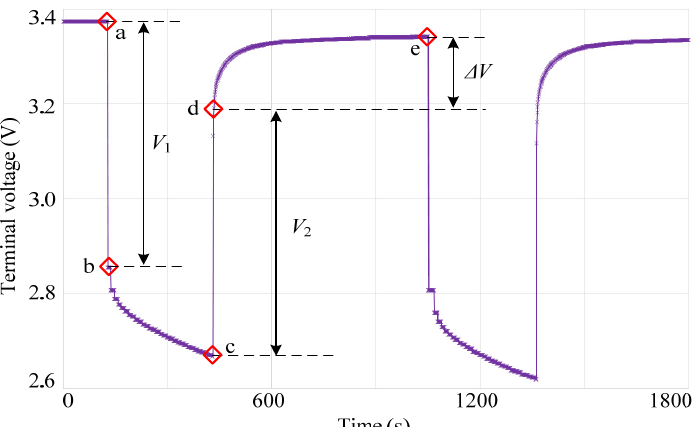
The functional relation between OCV and SOC is non-linear, and parameter identifica- tion in the battery state space model could be achieved through the change characteristics of the terminal voltage during the pulse discharge experiment. At the ambient condition of 25 ◦ C, the power battery is discharged along with the current of 1 C for 5 min, the discharge is stopped for 10 min, and then the battery is discharged for 5 min at the same current. A single pulse is selected to perform parameter identification on the battery model, and the dynamic curve of the battery’s terminal voltage is shown in Figure 4.